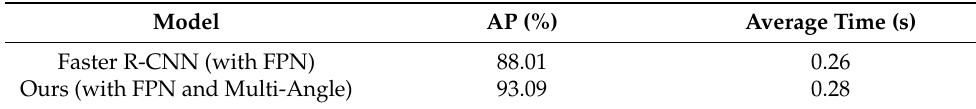
Table 6. Performance of models with different module on Dataset II.